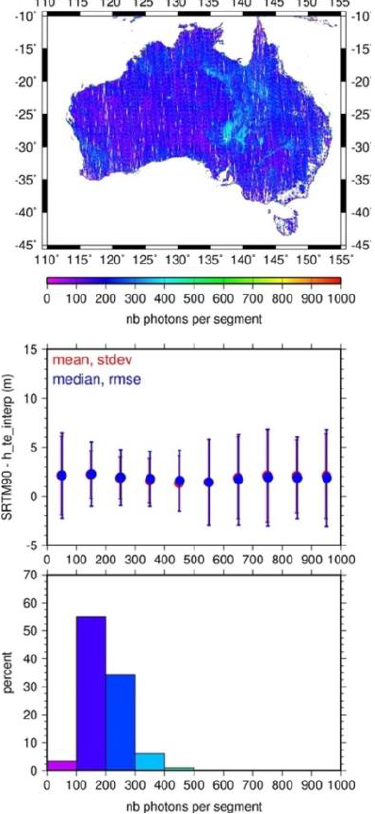
Figure 6. Differences between SRTM 90 m and ATL08 h_te_interp (in m) with respect to Number of Ground Photons per Segment ( n_te_photons ) for h_te_uncertainty less or equal to 7.5 m and %Tree cover less or equal to 5%. Mean, Median, Standard Deviations and RMSE are shown using 100 photons bin increments.